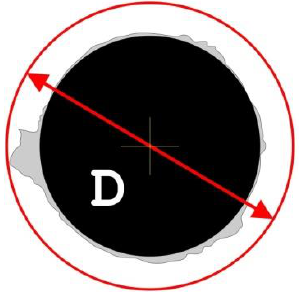
Figure 2. Sample photos of the hole taken on both sides of the particleboard.